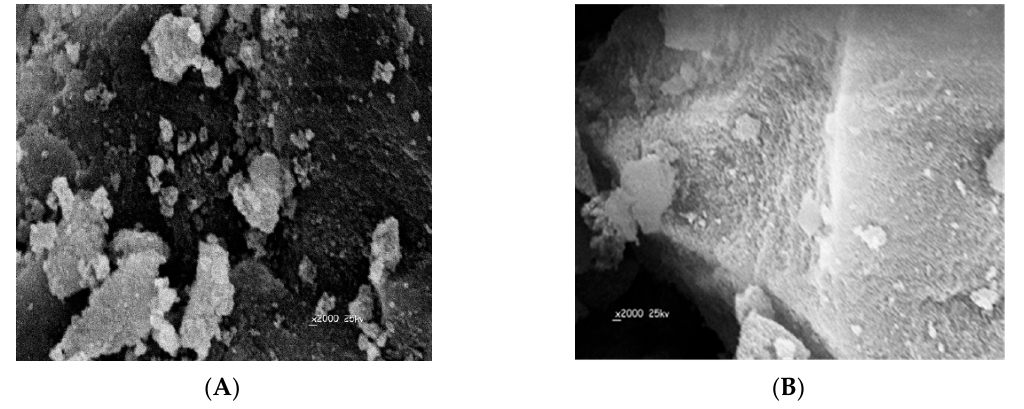
Figure 3. Electron microscopy (SEM) images of: ( A ) MIP and ( B ) NIP. Table 1. Characteristics of DMA sensors under static and flow-through modes of operation in 5 mmol·L –1 Trizma buffer, pH 7.1.